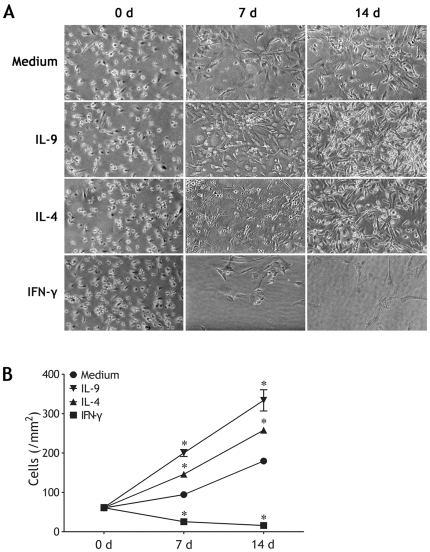
Effects of IL-9, IL-4 and IFN-γ on long-term restoring of pleural mesothelial cells (PMCs).(A) Pleural mesothelial cells were seeded in Petri dishes in complete medium in the presence of IL-9, IL-4 or IFN-γ for 14 d to allow for their growth. Representative of 5 independent experiments (Original magnification: ×400). (B) Comparisons of PMC numbers in each group (n = 5). The comparisons were determined by Kruskal-Wallis one-way analysis of variance on ranks, *p<0.05 compared with medium control at the same time points.